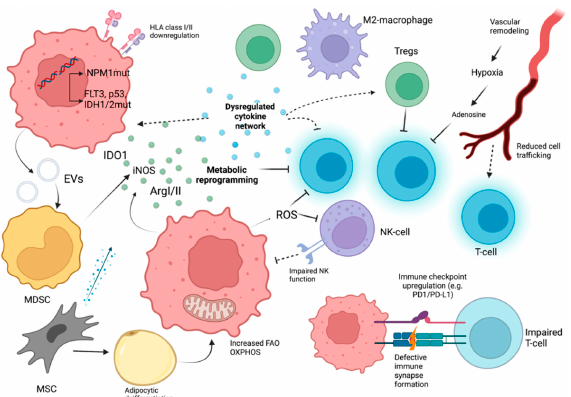
Figure 2. The immune landscape in AML. A complex network of AML cell-extrinsic and intrinsic factors characterize the immune microenvironment of AML. AML-related somatic mutations are implicated in immune alterations (with NPM1mut involved in effective T-cell immune responses). HLA molecule downregulation and defective antigen presentation are also recruited. Altered cyto- kine balance also assists AML cell expansion, Treg function, and immune suppression. A number of metabolic factors (IDO1/iNOS/ArgII elevation, increased fatty acid oxidation, and oxidative phos- phorylation) contribute to immunosuppression. MDSC expansion (possibly through MUC1 con- taining extracellular vesicles) and M2-macrophages also augment AML immune escape. Immune checkpoint molecule overexpression on AML and CD8+ T-cells (e.g., PD-1/PD-L1, TIM-3/galectin- 9), poor immune synapse function, and impaired NK –cell function (through NK-cell receptor downregulation, defective NK degranulation, and perforin binding). BM vascular remodeling im- pedes anti-AML immune responses through reduced cell migration and hypoxia induction.